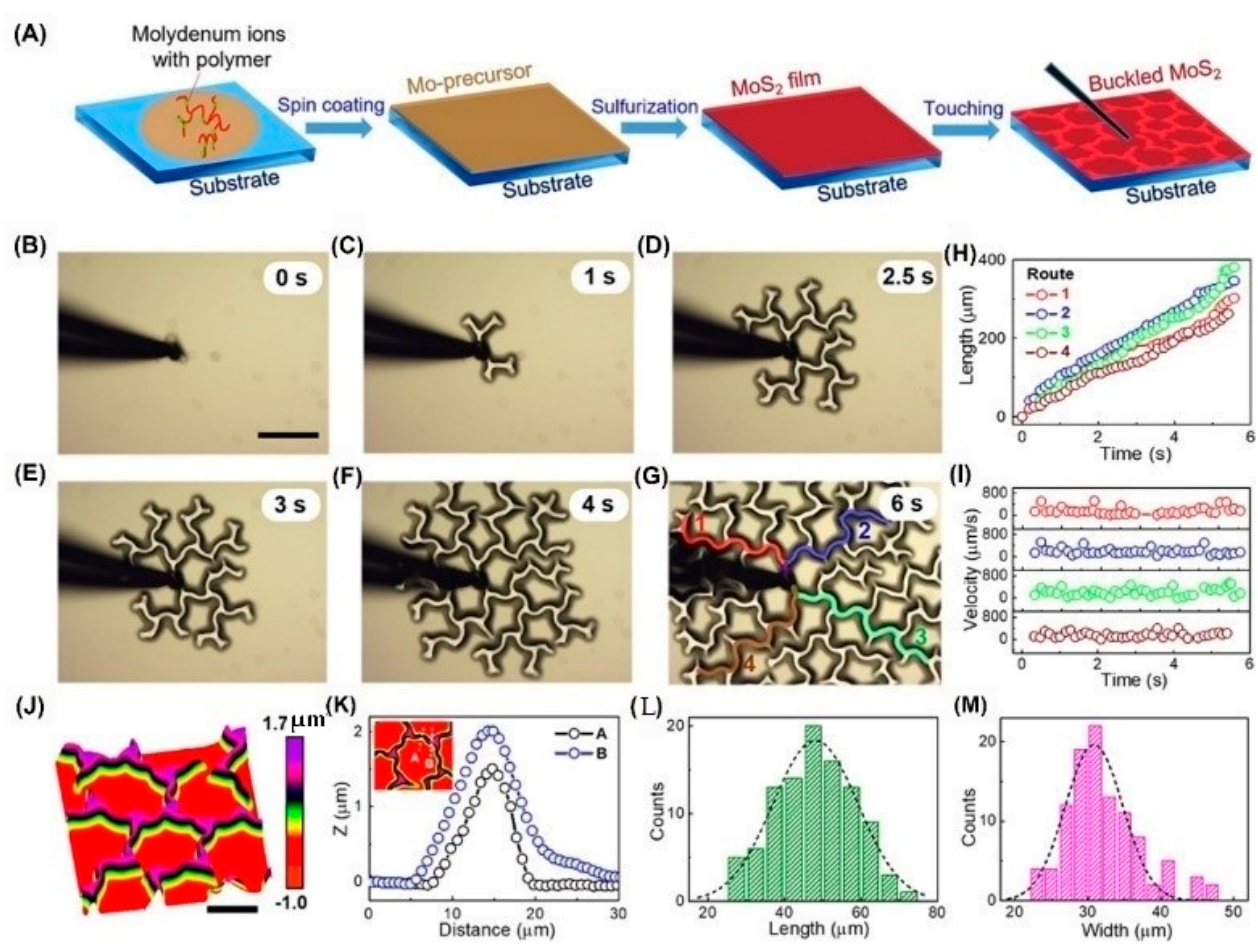
Figure 5. Formation of large-area web buckles. ( A ) Schematic illustration of the growth of a MoS 2 thin film with PAD and the triggering of buckles by a probe touching. ( B – G ) In situ observation of large area web buckles formed on an as-grown MoS 2 thin film with a thickness of 370 nm. Scale bar, 100 µm. ( H , I ) Propagating distances and velocities of buckles along four different branches as labeled in ( G ), as a function of time, respectively. ( J ) AFM 3D topography of a buckled MoS 2 thin film with a thickness of 230 nm. Scale bar, 20 µm. ( K ) Two height -profile lines crossing the middle of a telephone cord (line A) and a node position (line B) as shown in the inset. ( L , M ) Statistical histograms of lengths and widths of buckles. Reprinted/adapted with permission from Ref. [73]. Copyright 2019, American Chemical Society.